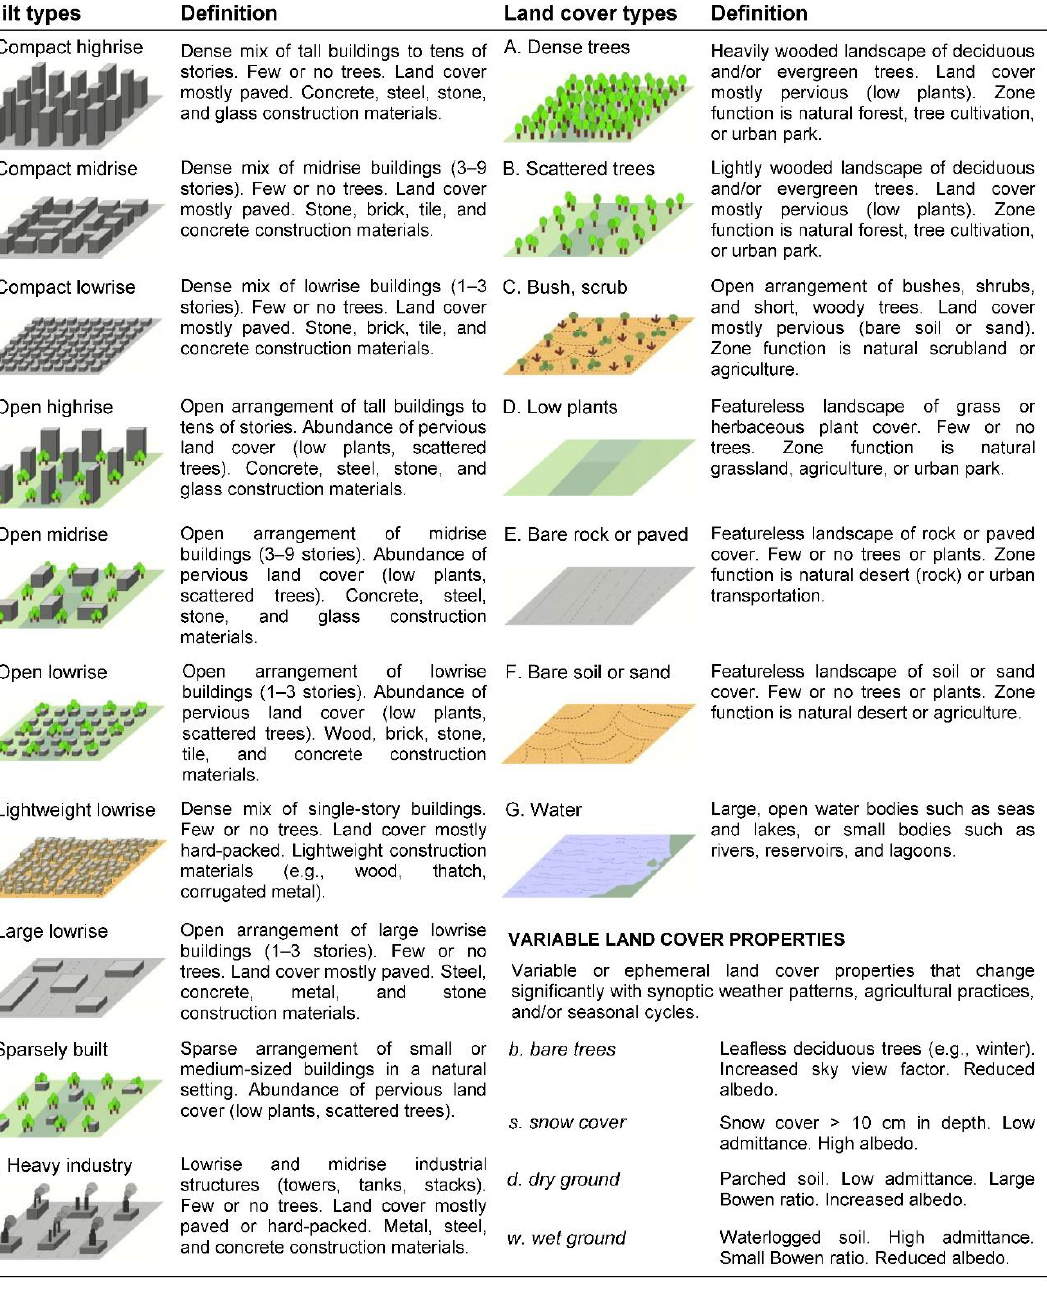
Figure 1. Built ( 1 – 10 ) and natural ( A – G ) Local Climate Zone (LCZ) types and their characteristics [5]. © American Meteorological Society. Used with permission.